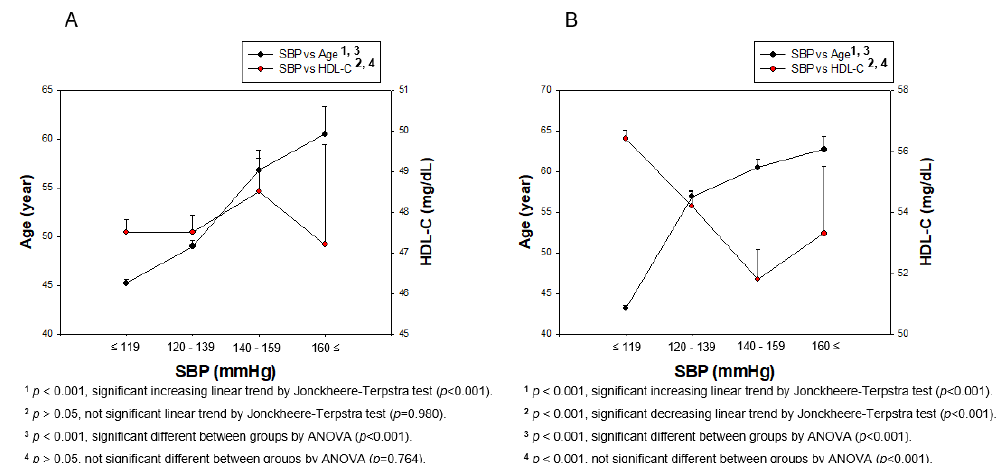
Figure 3. Correlation of age and HDL-C depends on SBP in men ( A ) and women ( B ). A negative association was found between age and HDL-C depending on SBP in women ( B ) by J–T test. Pearson’s correlation analysis was carried out between age, HDL-C, and SBP in men ( A ) and women ( B ). The men ( A ) showed r = 0.233 ( p < 0.001) and women ( B ) showed r = 0.468 ( p < 0.001) between SBP and age. Men ( A ) showed r = 0.008 ( p = 0.713) and women ( B ) showed r = − 0.111 ( p < 0.001) between SBP and HDL-C.